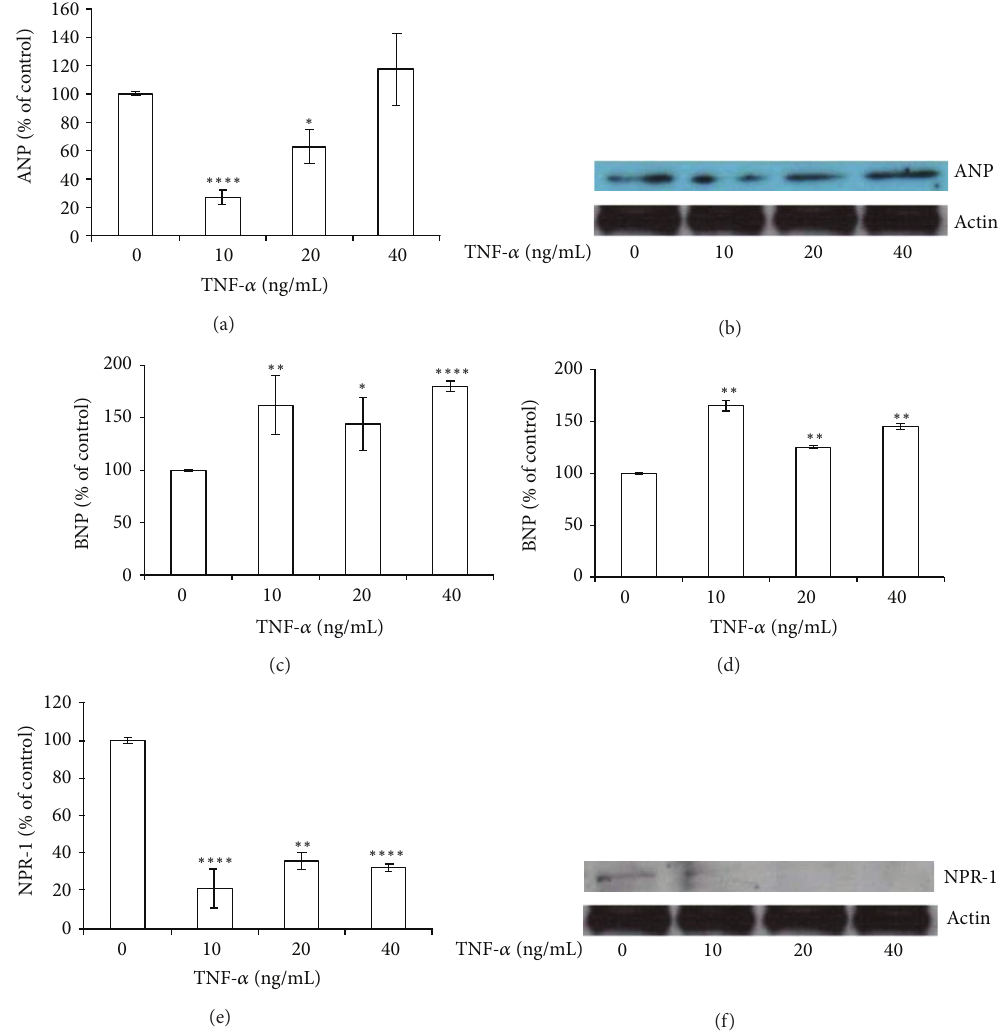
Figure 2: TNF- 𝛼 selectively modulates ANP, BNP, and NPR-1 expression. BEAS-2B cells were treated with 10, 20, and 40 ng/mL TNF- 𝛼 for 24 h. ((a), (b)) ANP, ((c), (d)) BNP, and ((e), (f)) NPR-1 gene expression at mRNA ((a), (c), and (e)) and protein level ((b), (d), and (f)). Western blots were obtained by using the specific rabbit polyclonal Abs. The blots were stripped of the bound Ab and reprobed with mouse anti- 𝛽 -actin, to confirm equal loading. Western blots are representative of three separate experiments. All histograms indicate means ± SD of three different cultures each one tested in quadruplicate and expressed as percentage of control ( ∗ 𝑃 < 0.05 , ∗∗ 𝑃 < 0.01 , ∗∗∗ 𝑃 < 0.001 , and ∗∗∗∗ 𝑃 < 0.0001 versus untreated